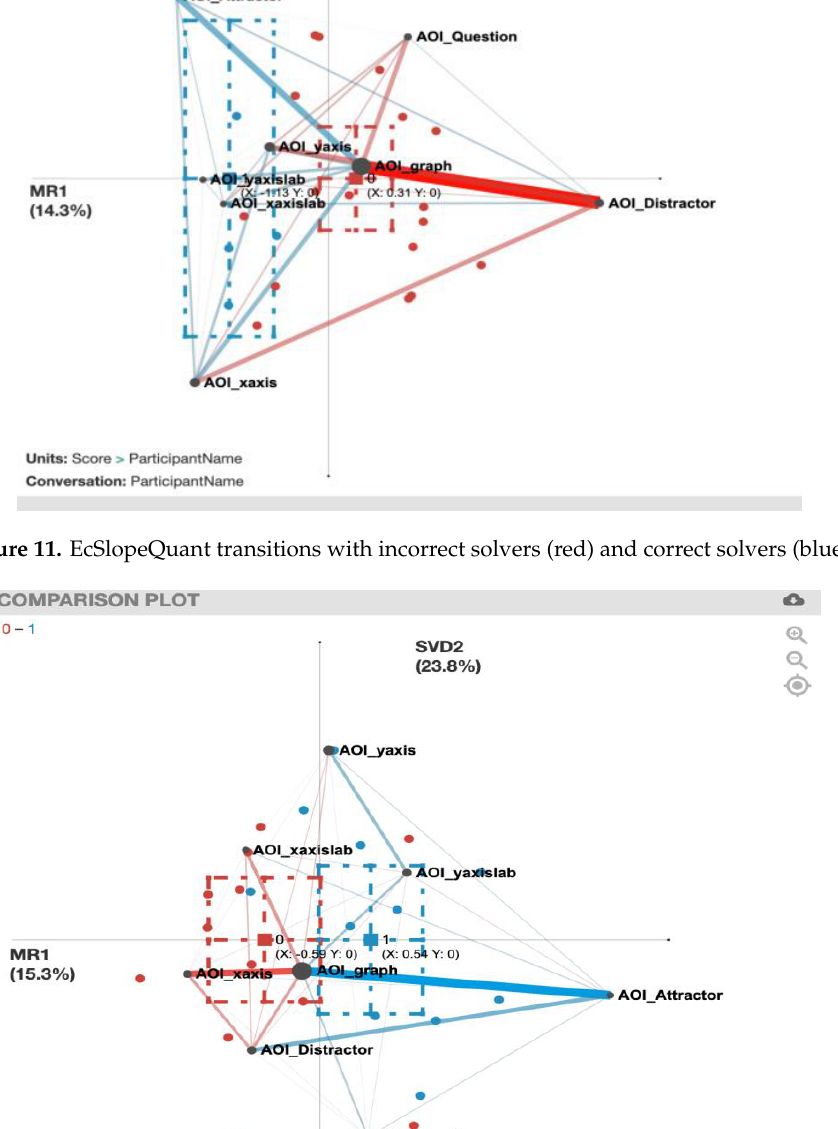
Figure 12. PhySlopeQuant transitions with incorrect solvers (red) and correct solvers (blue).